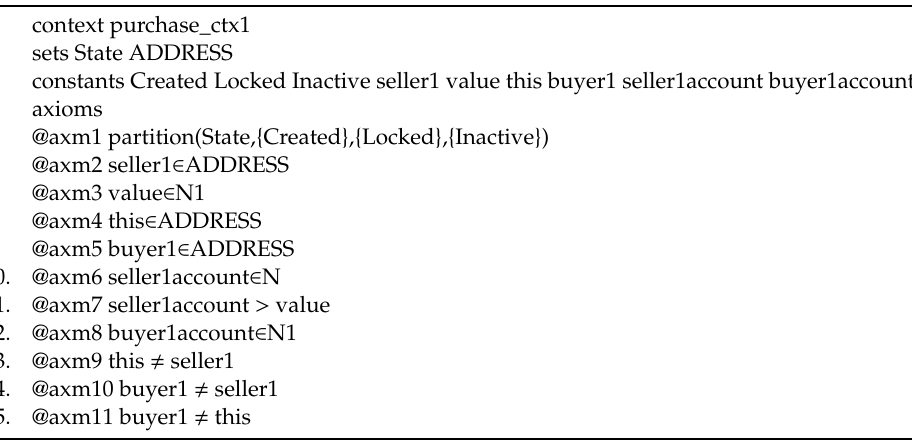
Table 1. Event-B’s context